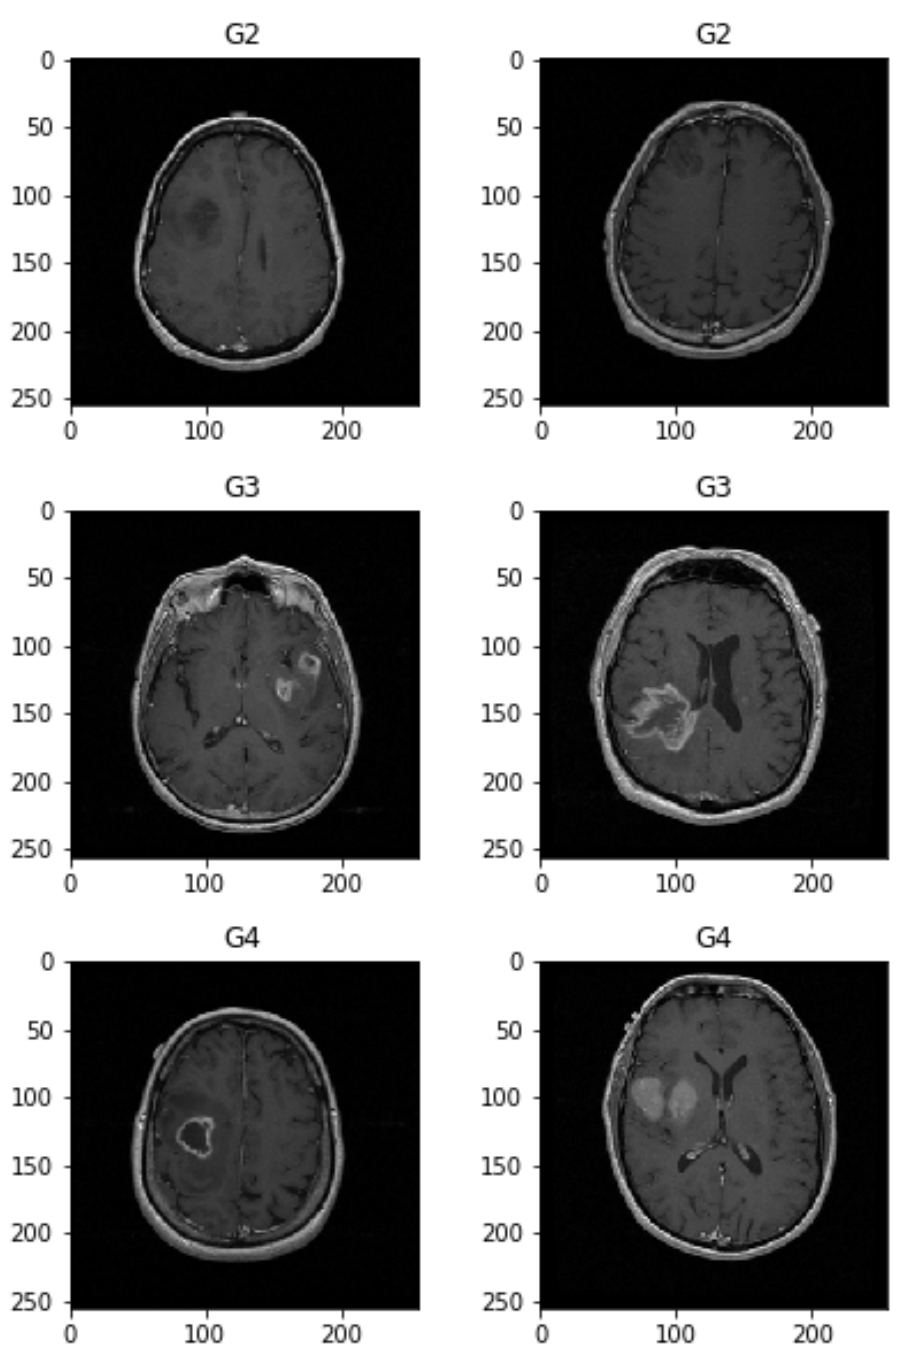
Figure 4. Axial MRI samples of different glioma grades: ( top ) glioma grade 2; ( middle ) glioma grade 3; ( bottom ) glioma grade